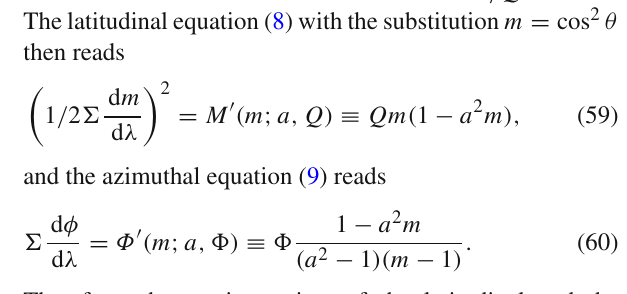
Fig. 8 Shift of nodes for the polar spherical orbits r pol ± represented by the isolated points in Fig. 6 in independence on the dimensionless spin a